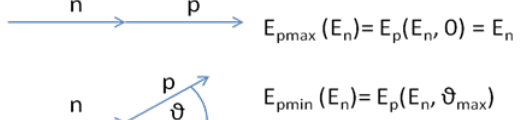
The neutron- γ discrimination is performed by the pulse- shape analysis. The dynamic threshold method is used for the calculation of the neutron energy spectrum from the measured pulse spectrum. The calculation is based on the counting of pulses with the amplitude higher than the threshold from the (p,n) scattering to angles between 0 deg. and some fixed angle (Figure 3).